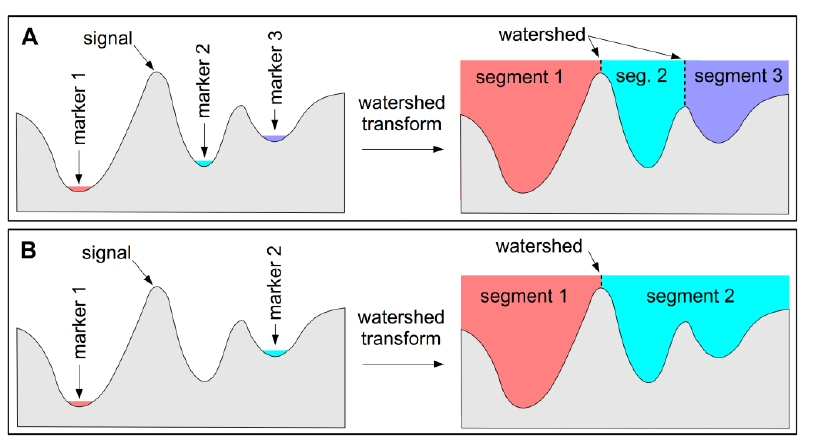
Figure 3. Two examples of the watershed transform applied to a 1-dimensional signal. ( A ) When three markers are located at the three local minima, three segments are formed with boundaries (watershed lines) on the local maxima; ( B ) When only two markers are selected, segment 2 floods over a peak and into the neighboring trough, until a boundary is formed with segment